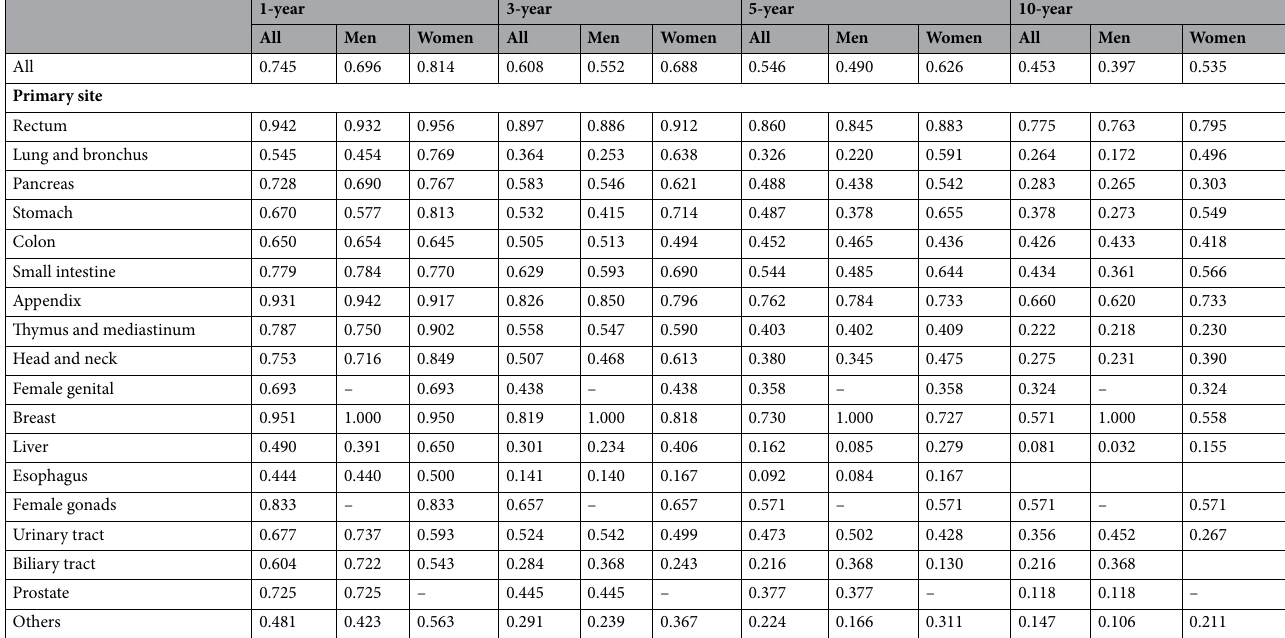
Table 3. The 1-, 3-, 5-, and 10-year overall survival rates of NETs by sites and sex in Taiwan